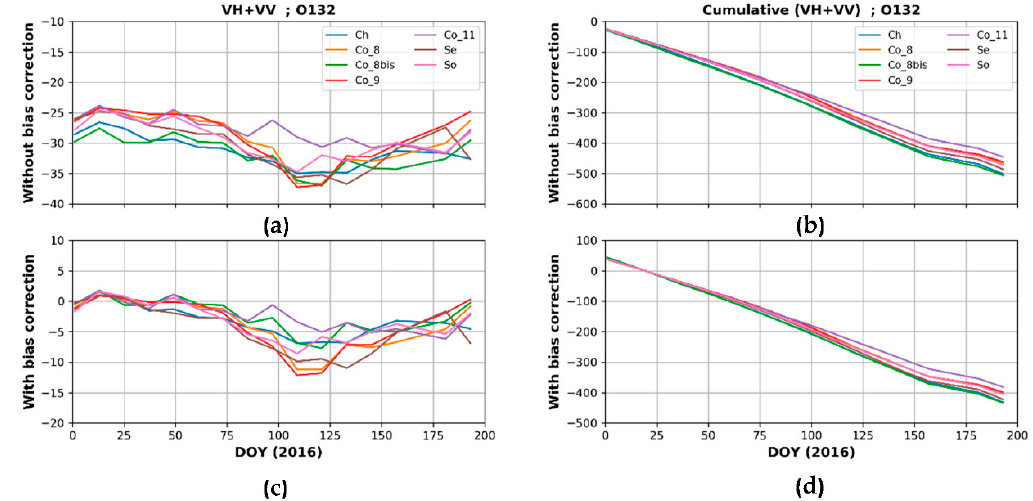
Figure 13. Temporal evolution of: the VH + VV ( a , c ) and its cumulative index ( b , d ) at orbit 132 for each field of wheat (2016): without and with bias correction respectively.